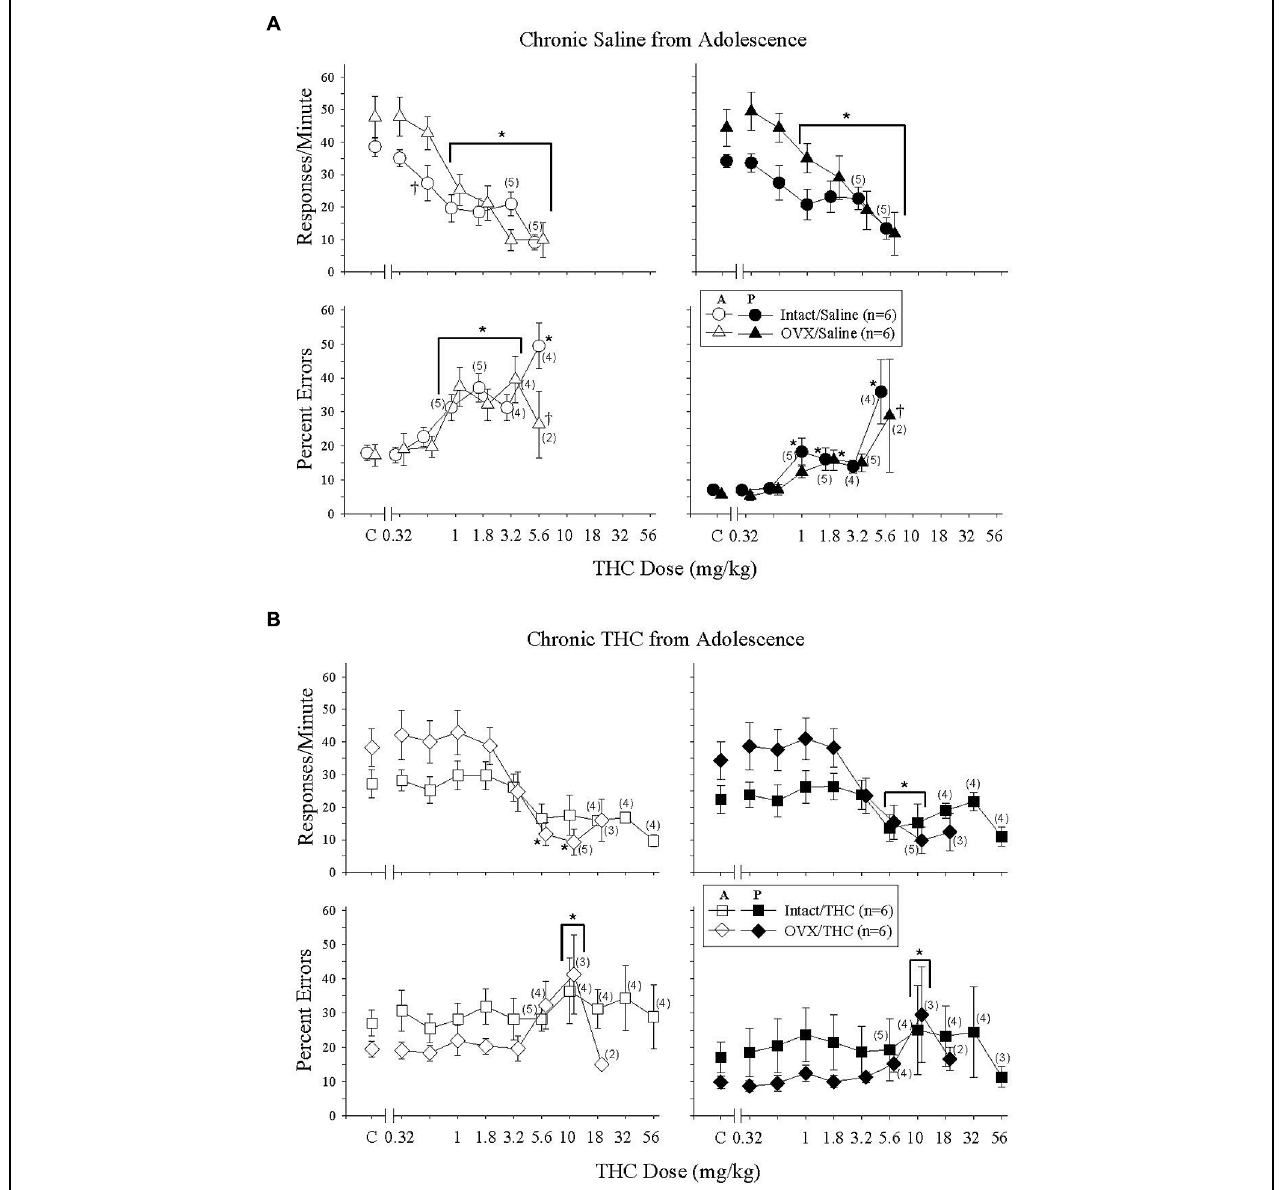
FIGURE 4 | Acute effects of (cid:2) 9 -THC in intact and OVX females that received either saline (A) or 5.6 mg/kg of (cid:2) 9 -THC (B) daily from adolescence to sacrifice and that were responding under an acquisition and performance procedure. Data points and vertical lines above C in each panel indicate the grand mean and SEM for 6–20 saline